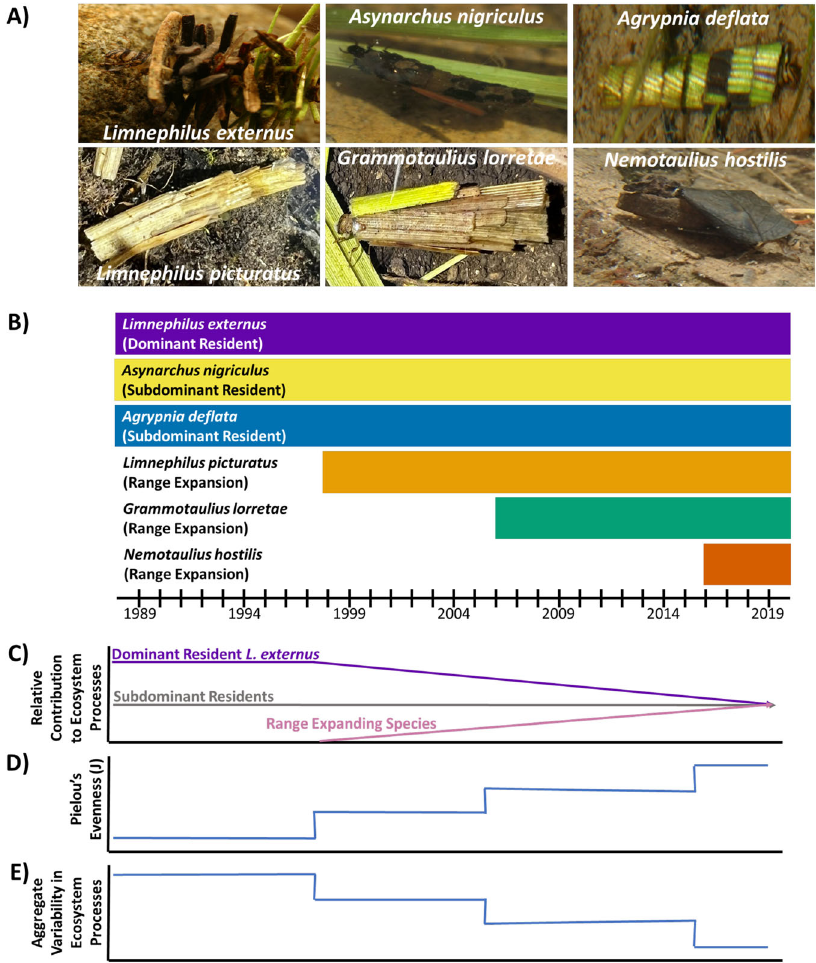
Fig. 1 Conceptual diagram of caddis fl y range expansions and hypothesized outcomes for caddis fl y assemblage evenness, aggregate variability in ecosystem processes, and relative contributions to ecosystem processes of dominant and subdominant residents and range expanding species. A Top row: photographs of larvae of resident caddis fl y species; bottom row: photographs of larvae of range expanding caddis fl y species. B Timeframes of the presence of each species at the Mexican Cut. Resident L. externus (numerically dominant caddis fl y), As. nigriculus , and Ag. de fl ata were present since long- term surveys began in 1989. Range expanding L. picturatus arrived in 1998, followed by G. lorretae in 2006, and most recently N. hostilis in 2016. C We expected relative contributions of L. externus to ecosystem processes to decline following arrival of range expanding species because we expected these species to provide larger relative contributions to ecosystem processes over time. D We hypothesized that caddis fl y assemblage evenness would increase as range-expanding species arrive at Mexican Cut and dominance of L. externus would decline. E Similarly, we hypothesized that greater caddis fl y assemblage evenness over time would provide greater functional redundancy and thus reduce aggregate variability in the assemblage ’ s contributions to ecosystem processes. Here, aggregate variability includes variability ecosystem process contributions among ponds and covariances among all species